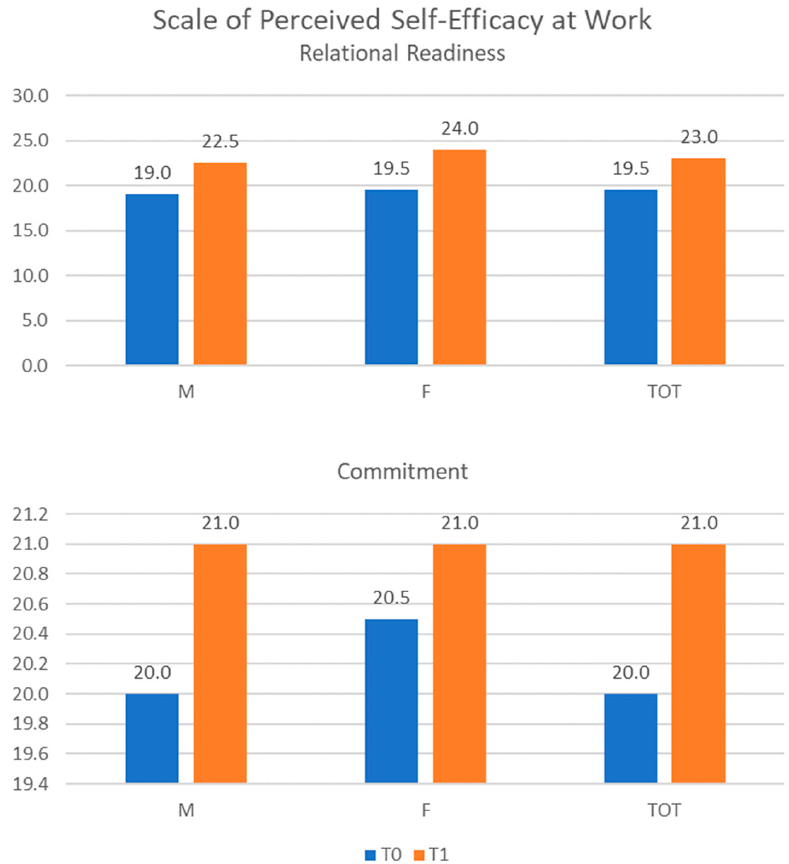
Figure 5. Scale of Perceived Self-Efficacy at Work scores. M = male; F = female; TOT = total.